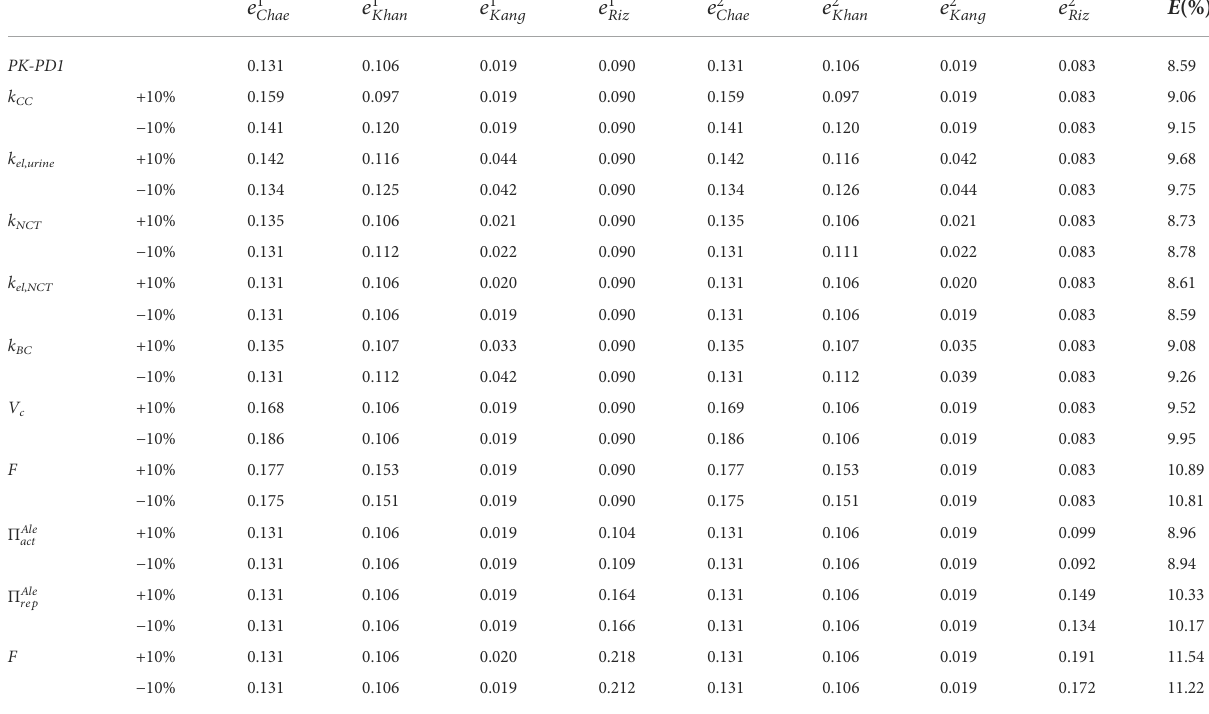
TABLE 3 Sensitivity analysis of the constants of the PK-PD1 model. The fi tted constants of the PK-PD model were varied by ± 10%, one at a time, keeping the rest constant. e k j is the error in each curve, where k = 1, 2 corresponds to f bm = 15% and f bm = 25%, respectively, and j = Chae , Kang , Khan , Riz indicates the curve. These error terms correspond toeach of the summations divided by the corresponding mean inEq. 30. E is the error as de fi ned in Eq.